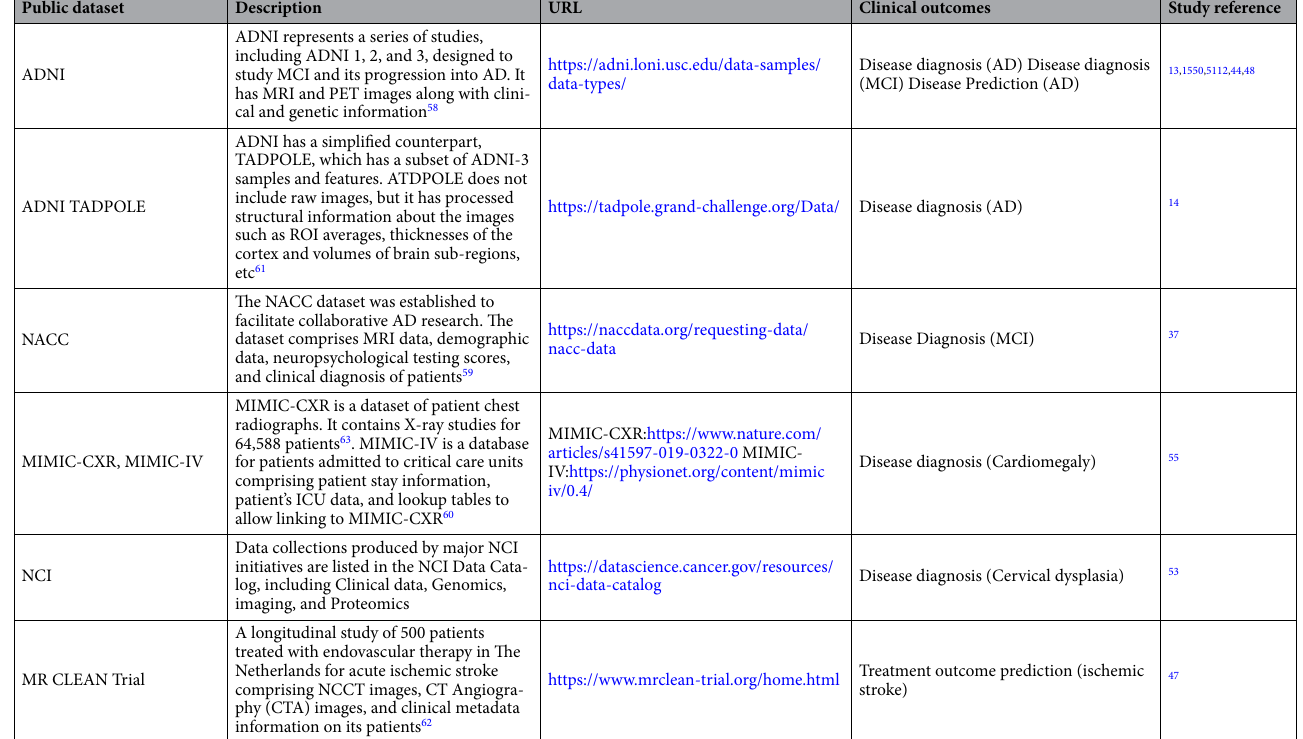
Table 5. Multimodal medical datasets and clinical outcome